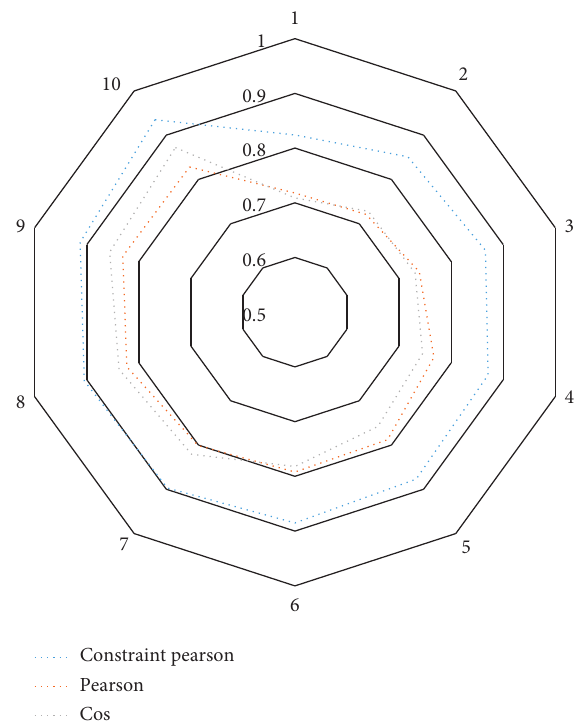
Figure 6: The impact of different similarity functions on recommendation